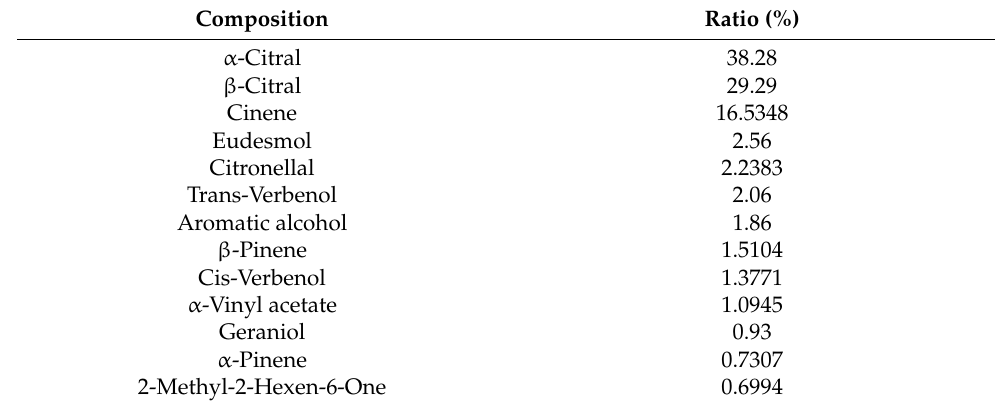
Table 1. Chemical compositions of L. cubeba essential oil